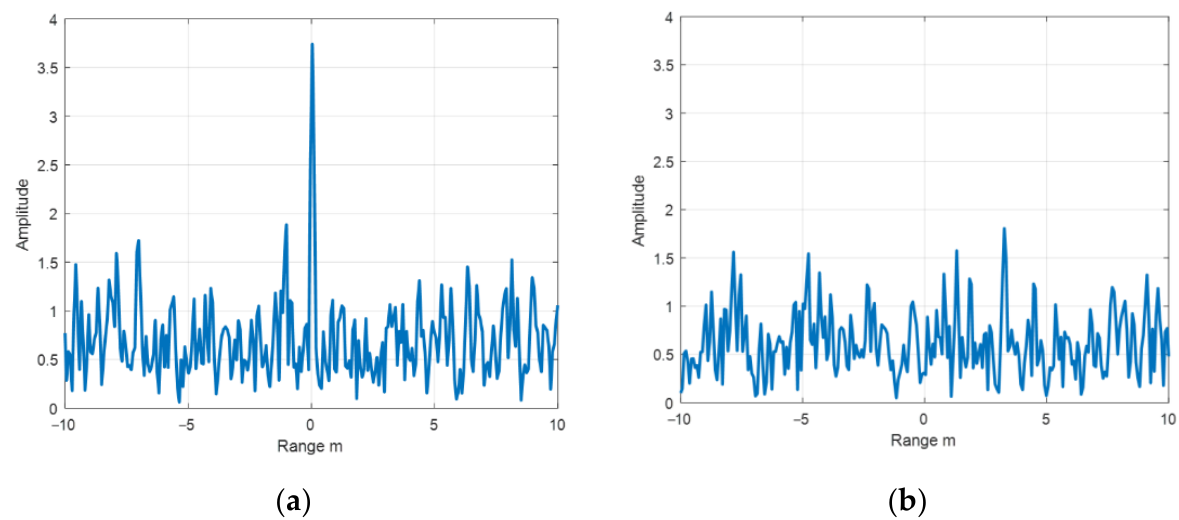
Figure 1. Echo diagrams of chirps with ( a ) SNR of 12 dB and ( b ) SNR of 0 dB.